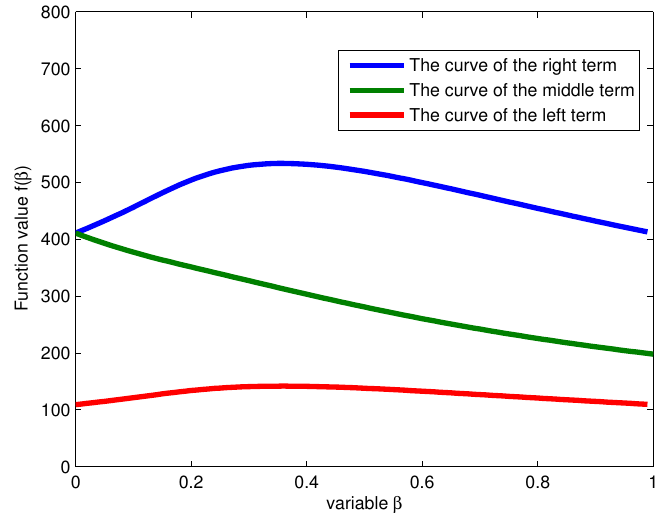
The curve of the right term The curve of the middle term The curve of the left term